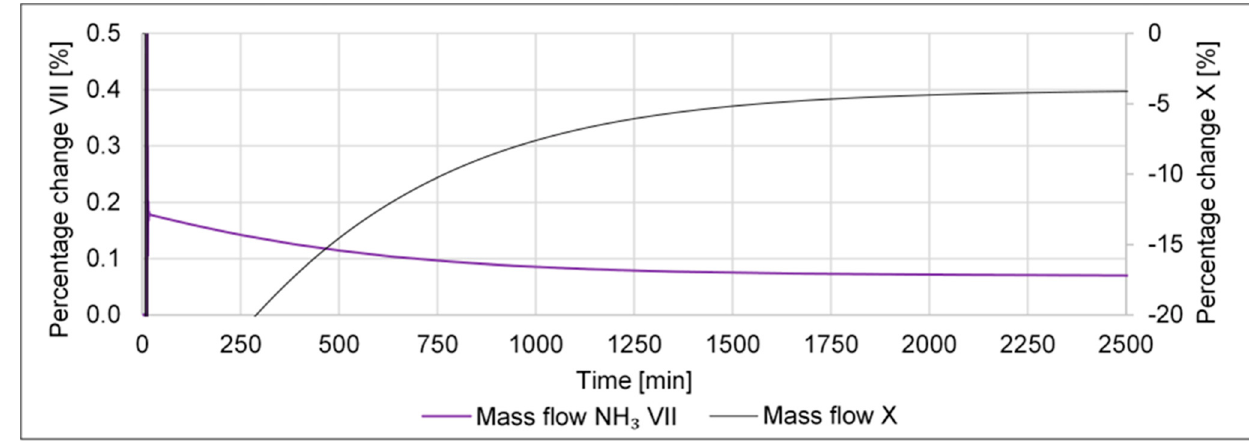
Figure 22 . Percentage change of mass fl ows NH3 VII and X (left and right vertical axis) of scenario Figure 22. Percentage change of mass flows NH3 VII and X (left and right vertical axis) of scenario (h).